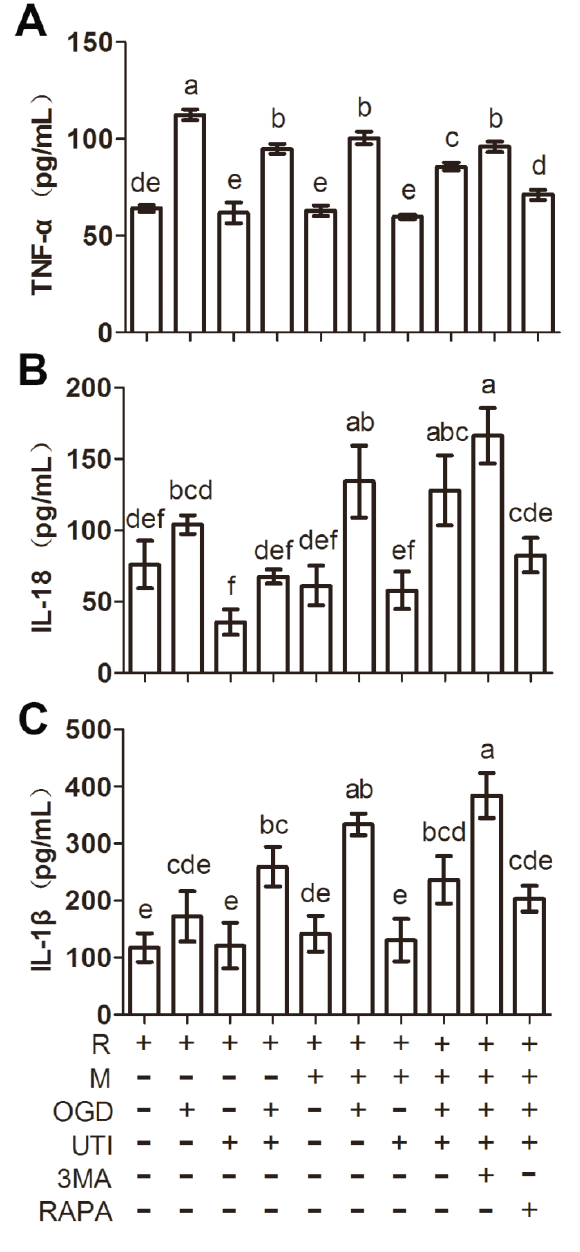
Figure 5: UTI affected the expression of inflammatory factors through autophagy. A: The concentration of TNF-α in the supernatant of renal tubular epithelial cells and macrophage and renal tubular epithelial cells co-culture system by ELISA analysis. B: ELISA analysis of the concentration of IL-18 in the supernatant of renal tubular epithelial cells and macrophage and macrophages co-culture system; C: The concentration of IL-1β in the supernatant of renal tubular epithelial cells and macrophages and renal tubular epithelial cells co-culture system by ELISA analysis. R: Renal tubular epithelial cells; M: Macrophage; OGD: Oxygen glucose deprivation; UTI: Ulinastatin.; 3MA: 3-Methyladenine; RAPA: Rapamycin. Bars with different letters are significantly different (p < 0.05).s